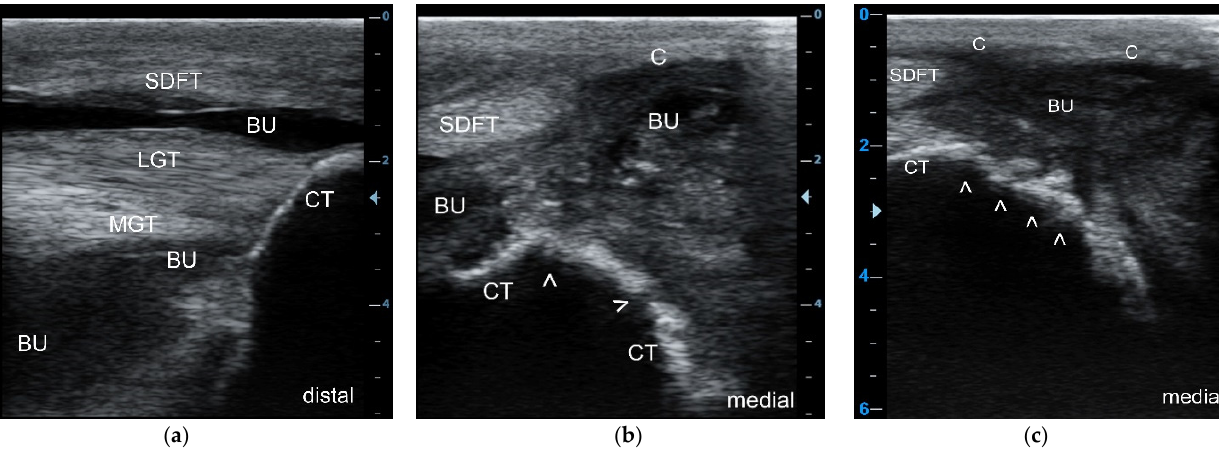
Figure 2. Longitudinal sonogram (5 MHz linear) of the CT region at the insertion site of the Achilles tendon ( a ), and transverse sonograms (5 MHz linear) of the plantaromedial ( b ) and medial aspect ( c ) of the proximal CT showing a septic purulent bursal effusion ( a ) and bone involvement (infection) in this cow; the bursal cavity (BU) is highly enlarged due to the presence of heterogeneous hypoechoic exudate with an anechoic, partly hypoechoic to echoic and “snow-flurry-like” appearance, the latter in particular at the medial aspect of the bursal cavity with flow phenomena ( b , c ), indicative of a purulent exudate. Due to the severe effusion, the superficial digital flexor tendon (SDFT) is displaced plantarily, as is the bursal capsule (C). The contour of the CT appears normal at the insertion site of the lateral (LGT) and medial gastrocnemius tendons (MGT) ( a ), but highly irregular (white arrows) at the plantaromedial ( b ) and, in particular, at the medial aspect of the CT ( c ) indicating extensive osteolysis.